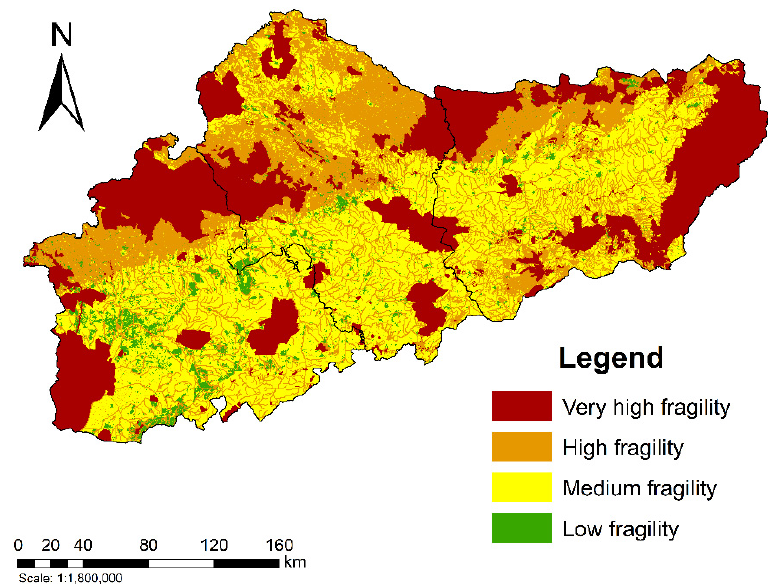
Figure 6. Environmental fragility map of the study area.